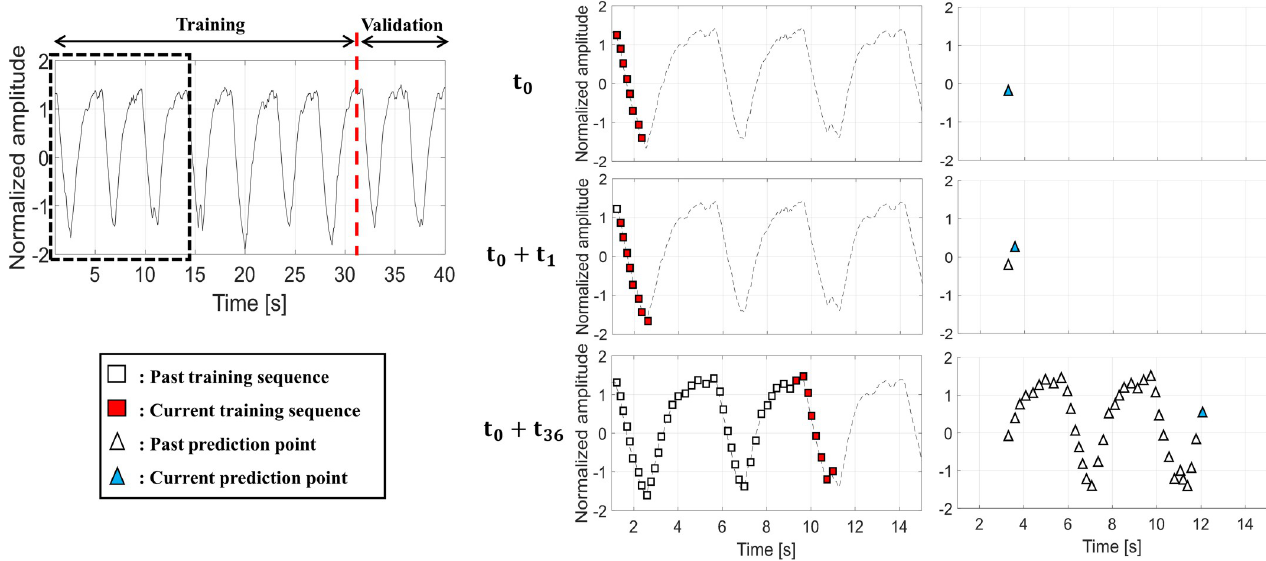
Fig 1. Process of learning a respiratory signal prediction model using deep